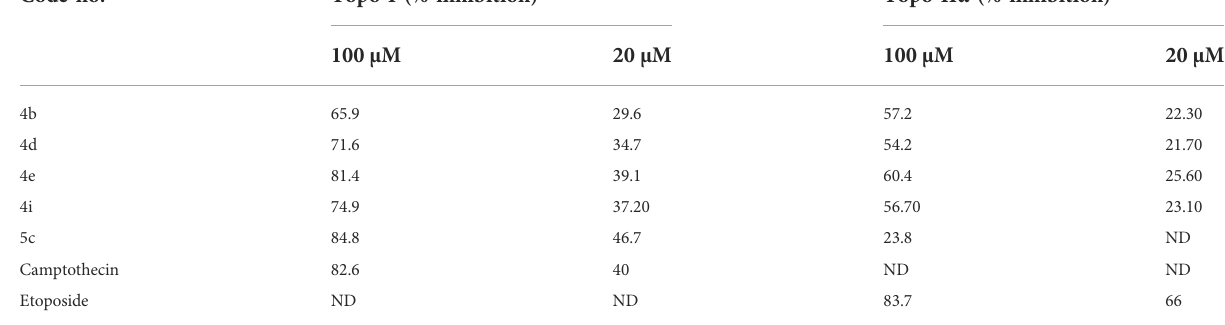
TABLE 2 Topo I and II α inhibitory activity of compounds 4b, 4d, 4e, 4i, and 5c. Code